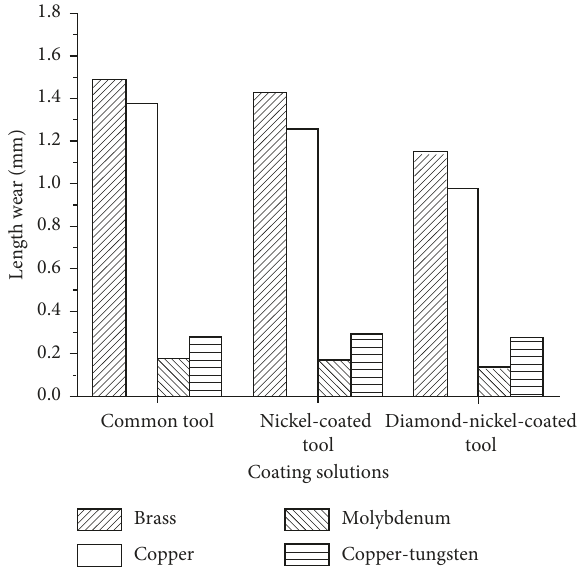
Figure 6: Length wear of different coated